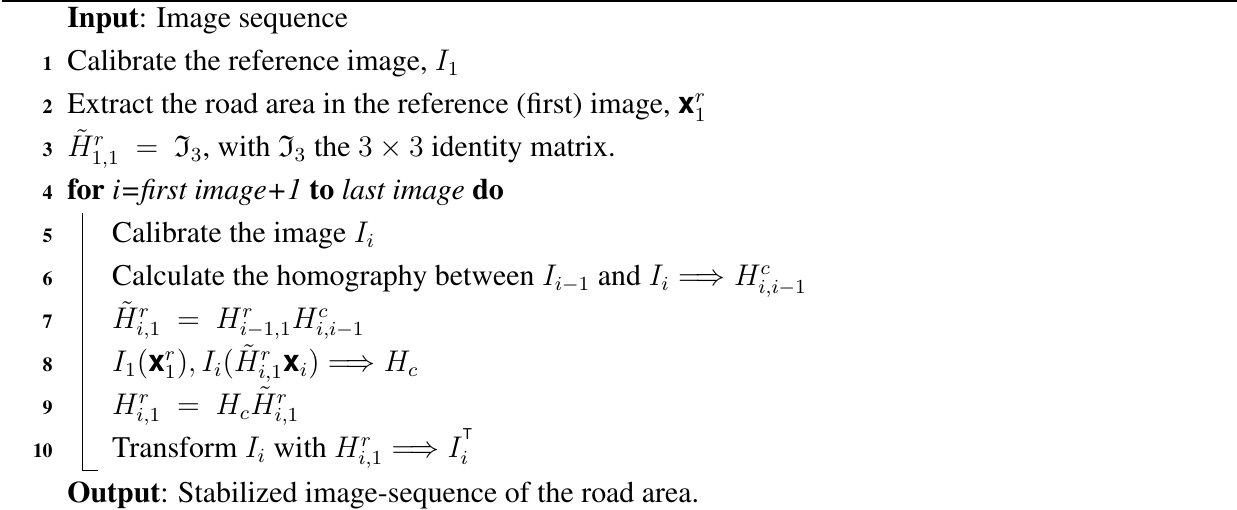
Algorithm 1: Framework of the image-sequence registration of the road